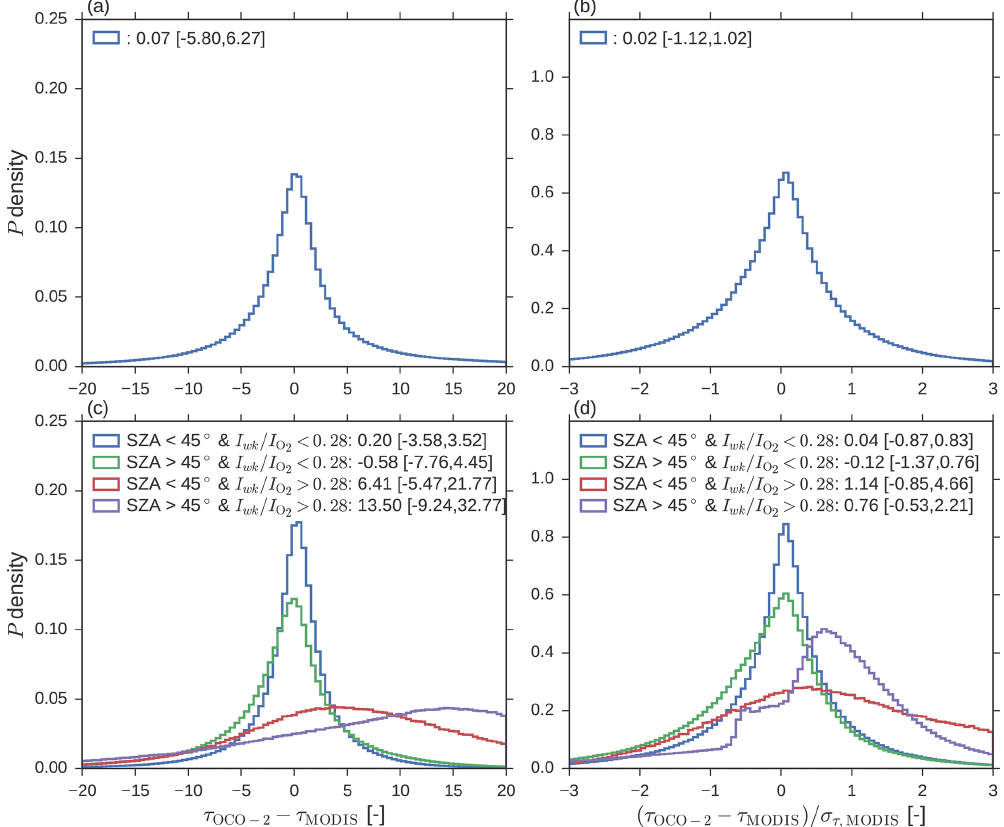
Figure 4. OCO-2 minus MODIS τ statistics; in all cases the legend reports the median [14th, 86th percentiles]. (a) All retrievals absolute dif- ferences. (b) As (a) but each difference is divided by the matching MODIS uncertainty. (c) Retrievals split by SZA and radiance ratio warning flag. (d) As (c) but divided by MODIS uncertainties as in (b) . These separations are part of the OCO2CLD-LIDAR-AUX Quality_flag: SZA above 45 ◦ adds 1 to Quality_flag, and I wk /I O above 0.28 adds 2